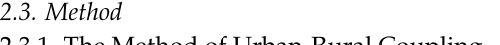
Figure 3. Urban–rural coupling relationship of ecological governance framework.